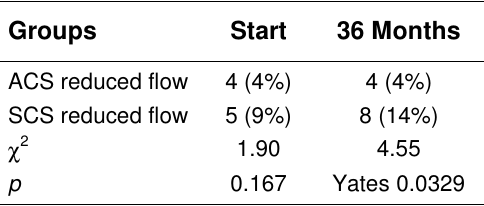
Number of Reduced Carotid Blood Flow Cases at the Beginning and End of the Study Groups